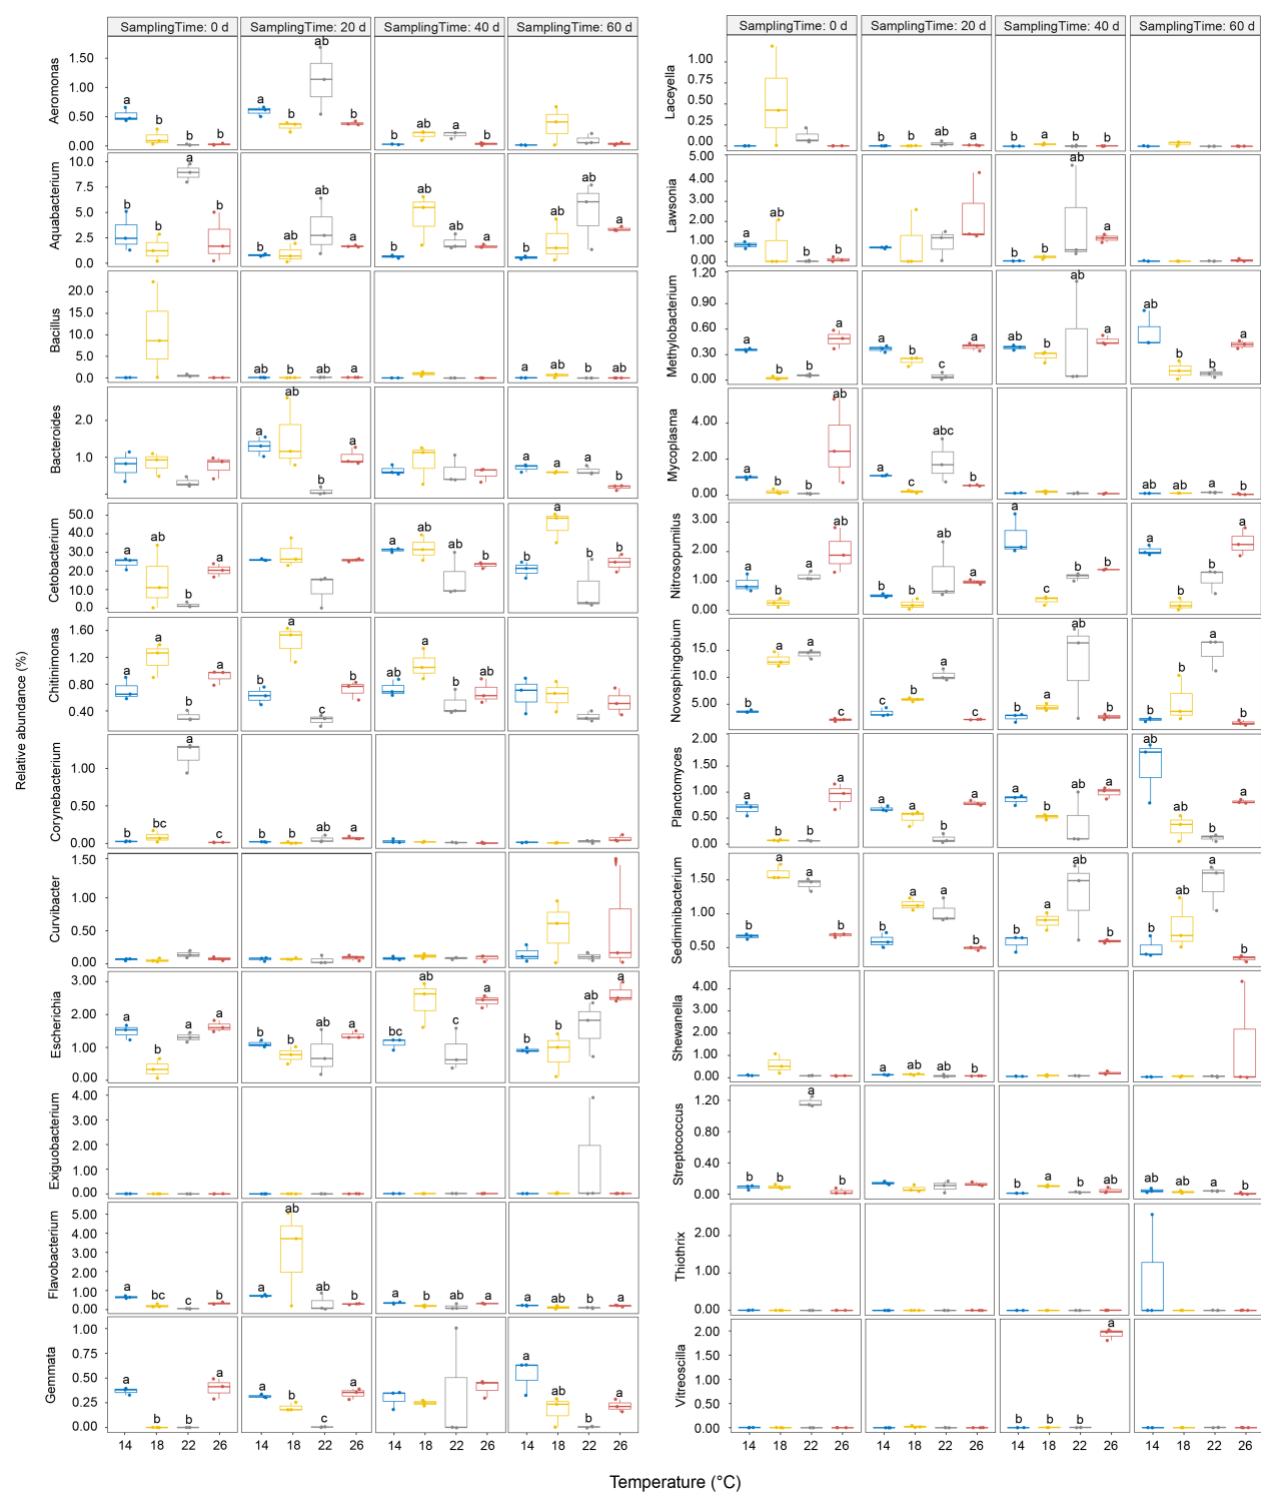
Figure 6. Relative abundance changes of commonly dominant genera of Percocypris pingi gut microbiota at different culture temperatures. Dots in the boxplots indicate values measured in samples. Distinct letters above the boxes indicate significant differences ( p < 0.05).